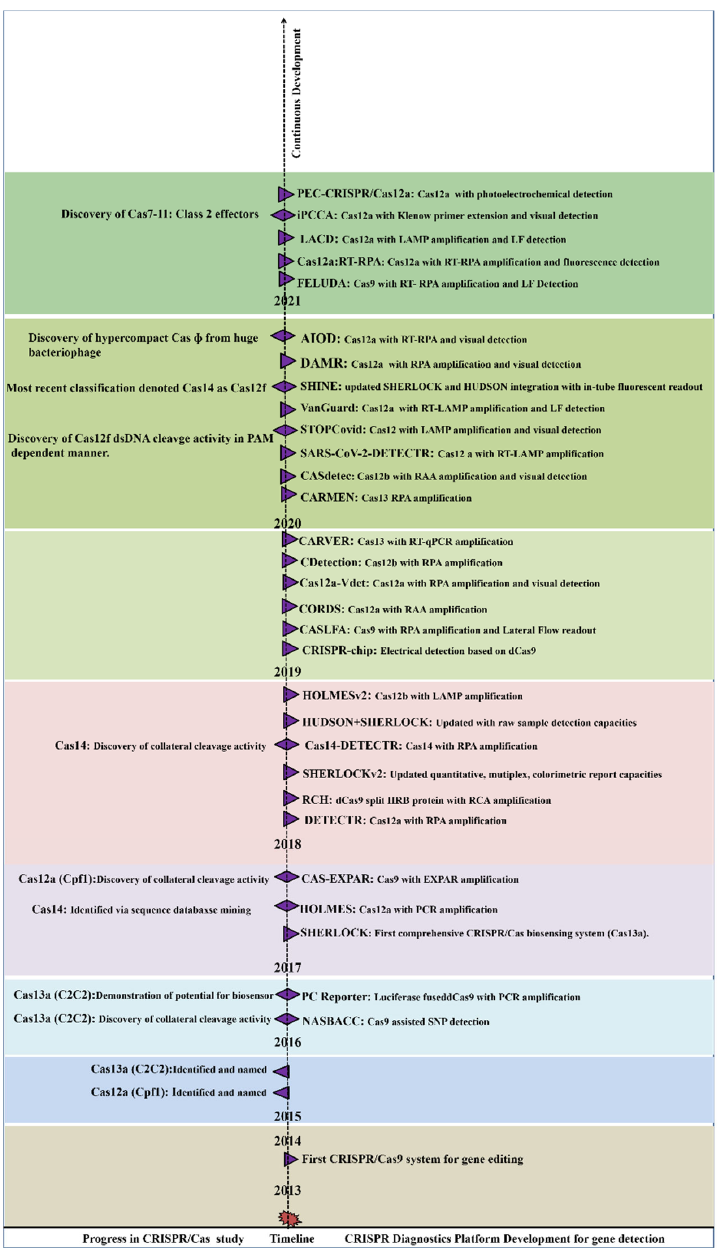
Figure 2. Year ‐ wise Discovery and development of CRISPR/Cas based Nucleic acid detection plat ‐ Figure 2. Year-wise Discovery and development of CRISPR/Cas based Nucleic acid detection form.